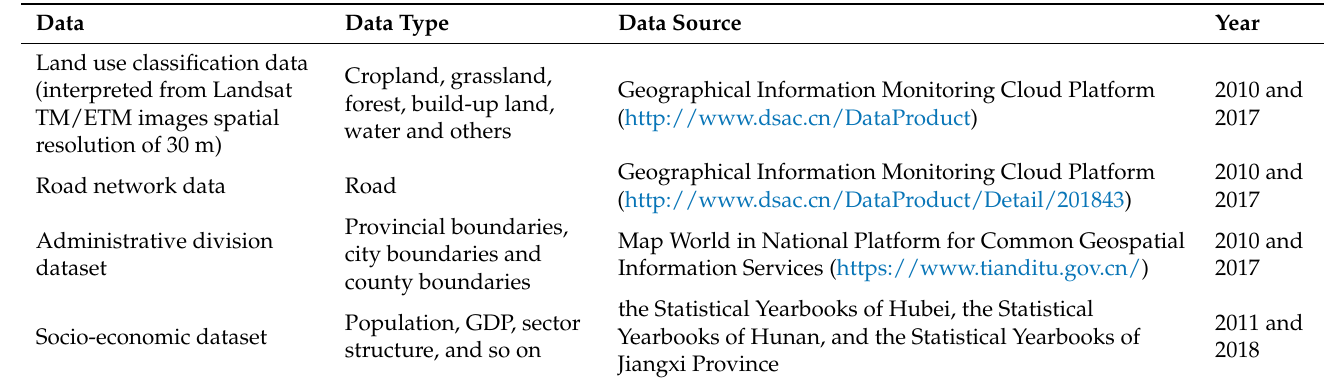
Table 1. Data and Data